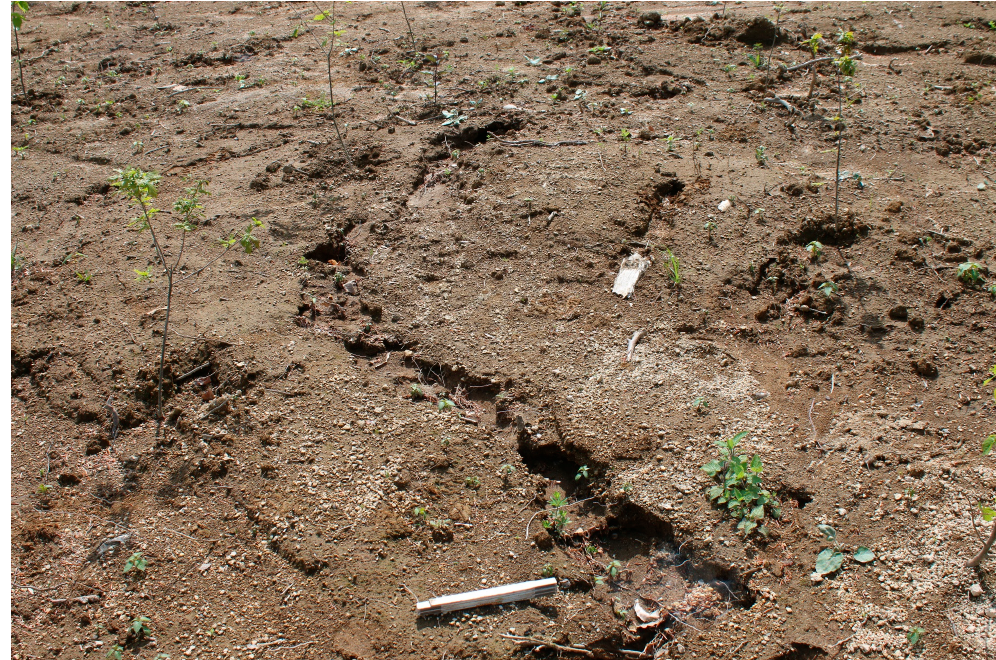
Figure 17. Example for an erosion rill on backfilled sub-area CUT, folding ruler for scale.